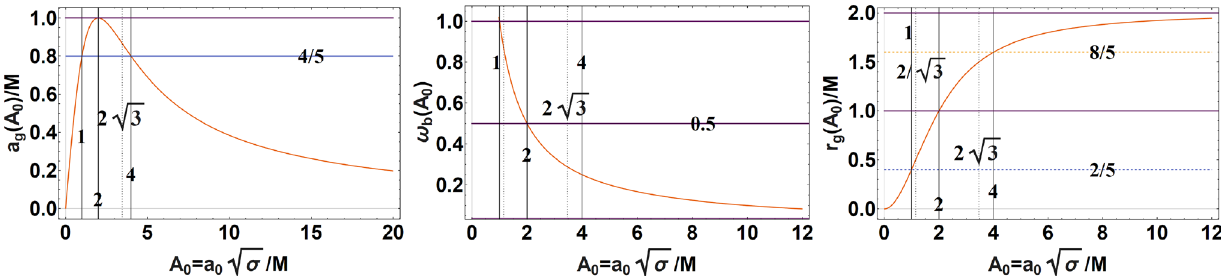
Fig. 5 Tangent spin a g ( A 0 ) (left panel), bundle frequency ω b ( A 0 ) (center panel) and tangent radius r g ( A 0 ) (right panel) of the bundle as functions √ σ , where a σ = sin θ 2 – see Eq. of A 0 ≡ a 0 0 is the bundle origin